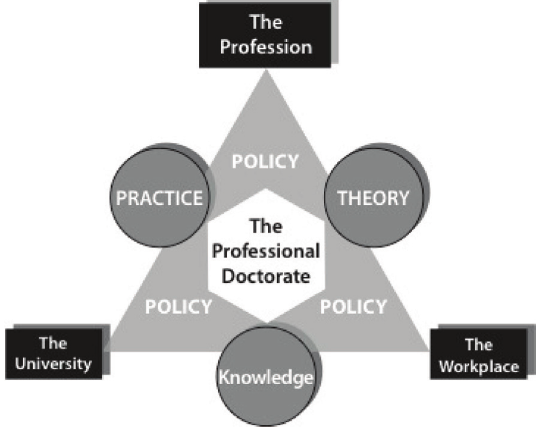
Figure 1: The professional doctorate – its purpose and distinctiveness